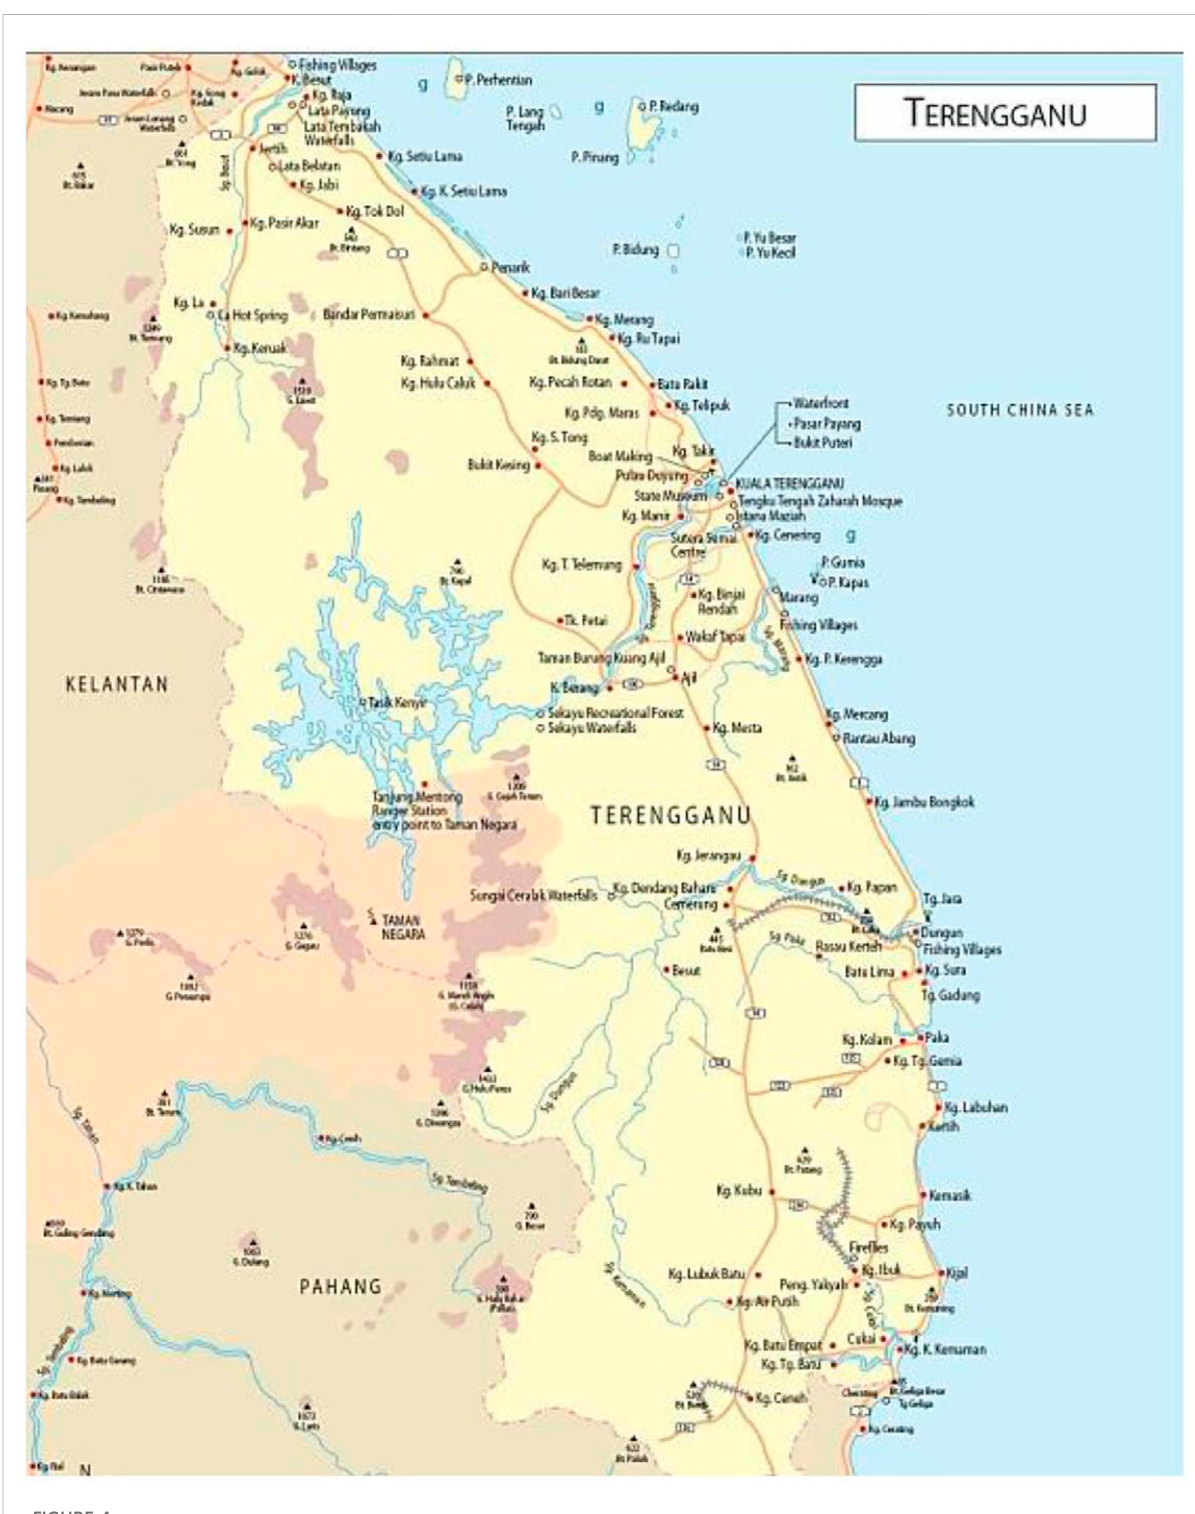
FIGURE 4 Terengganu river map (Source: